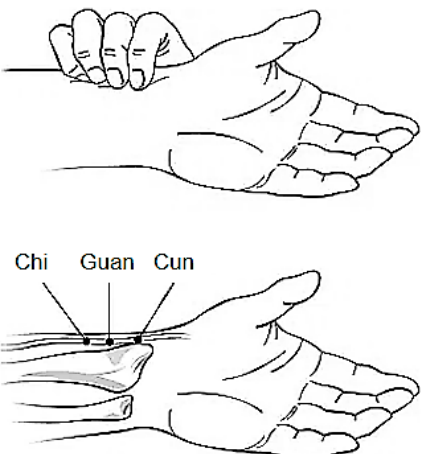
Figure 3. Pulse diagnosis gauge sites over the radial artery. Reprinted with permission from ref. [60], Copyright 2017 Cao Xuan